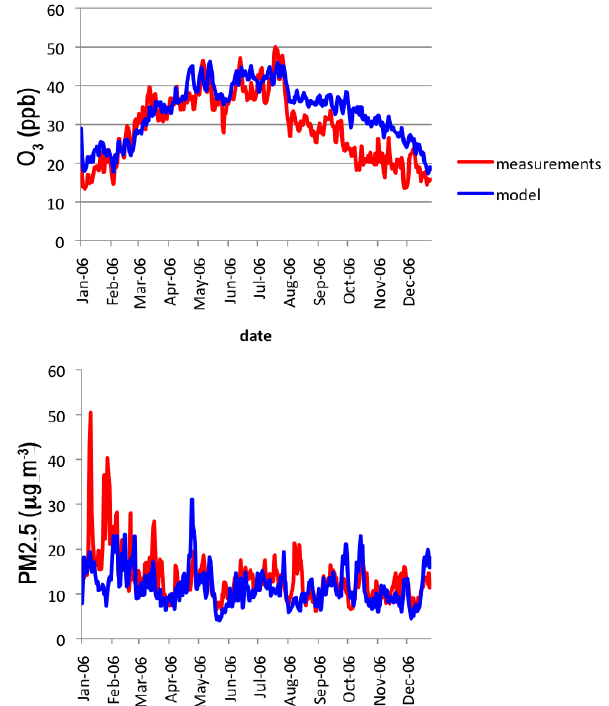
Figure 2. Time series of modelled (CAMx) and measured (AirBase) hourly average O 3 (ppb) (upper panel) and daily average PM 2 . 5 (µgm − 3 ) (lower panel) in 2006 (European domain). Number of measurement sites: 300 for O 3 , 19 for PM 2 . 5